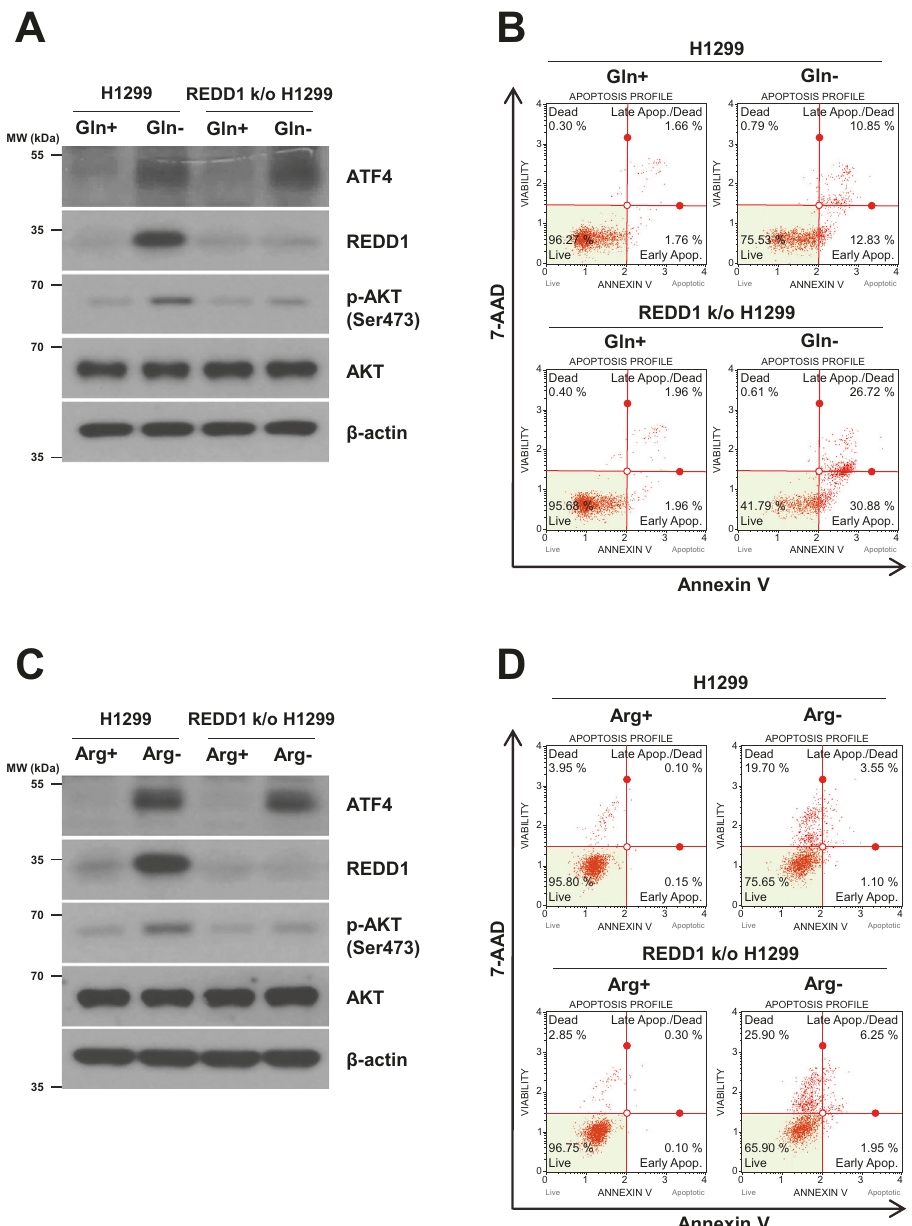
Fig. 7 CRISPR-Cas9-mediated knockout of REDD1 suppresses AKT activation and enhances cell death in glutamine- or arginine-deprived cells. A – D H1299 and CRISPR/Cas9-mediated REDD1-knockout H1299 cells were incubated in complete medium or medium lacking glutamine or arginine for 24 h. A , C The levels of the indicated proteins were measured by western blot analysis. B , D Cell death was detected as the percentage of Annexin V and/or 7-AAD positive initiated by general control nonderepressible 2 (GCN2) upon methionine or lysine signi fi cantly inhibited mTORC1 activity. amino acid deprivation. Our study and other studies have Deprivation of these amino acids induced the expression of REDD1, reported that ATF4 is critical for the increased expression of a negative regulator of mTORC1. A recent study reported that REDD1 [12, 13]. In our current study, ATF4 protein expression was upregulated REDD1 expression is involved in resuppression of increased in cells cultured in medium lacking glutamine, arginine, mTORC1 during prolonged leucine deprivation [27]. However, in our methionine or lysine, which induced REDD1 expression. ATF4- experimental system, leucine deprivation did not affect REDD1 silenced cells displayed decreased REDD1 expression and expression or mTORC1 activity. These fi ndings suggest that the sustained mTORC1 activity upon deprivation of glutamine or ability of a given amino acid to regulate mTORC1 activity might differ arginine, suggesting that ATF4 is required for REDD1 induction according to cell type and severity of the stress encountered. and mTORC1 inhibition in response to amino acid deprivation. Activating transcription factor 4 (ATF4) is a basic leucine zipper Knockdown of GCN2 abrogated ATF4 and REDD1 induction and transcription factor that is selectively translated in response to led to sustained mTORC1 activity upon deprivation of glutamine speci fi c forms of cellular stress to induce the expression of genes or arginine, indicating that GCN2/ATF4 signaling is required for involved in adaptation to stress [28]. The adaptive program is